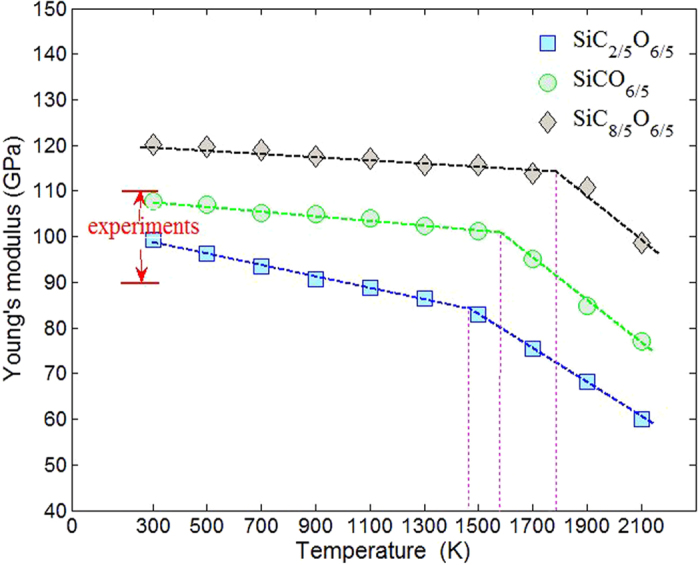
Young’s modulus of the amorphous SiCxO6/5 structures.